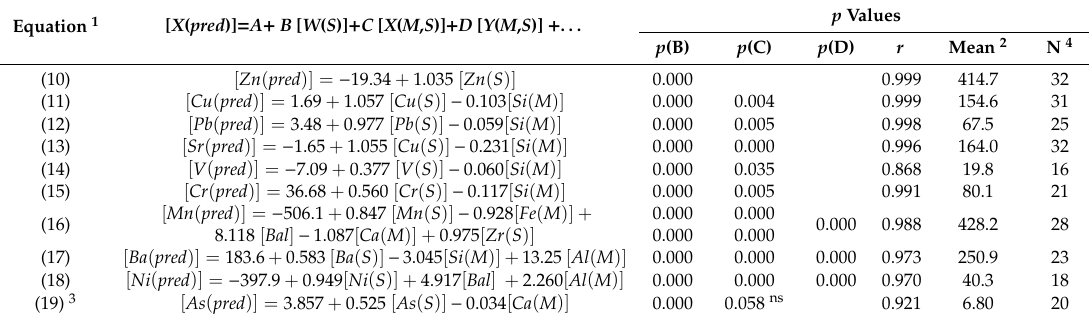
Table 6. Linear equations for the prediction of aqua regia extractable contents of trace metal (X(pred) from the readings obtained by the